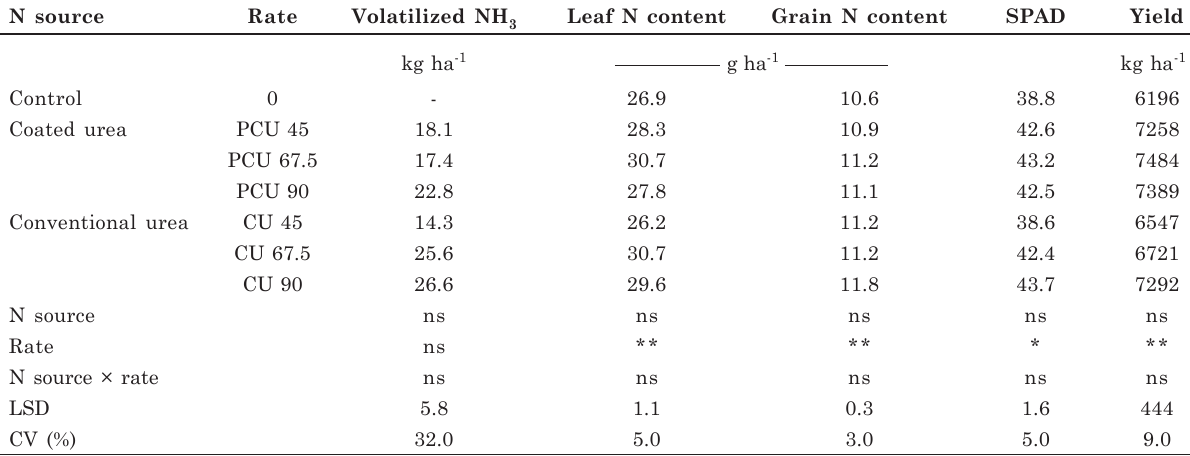
Table 2. Loss of volatilized NH 3 -N, nitrogen concentration in maize leaves and grains, SPAD readings and grain yield followed by the significance of the